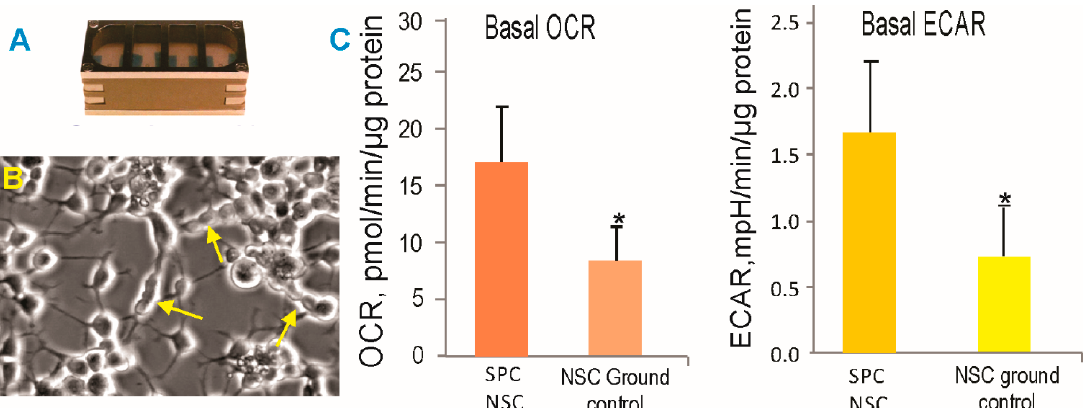
Figure 3. SPC-NSCs and ground control NSCs were recovered from the passive hardware ( A ) and treated in the same manner. ( B ) Representative example of post-flight NSCs that continued to actively proliferate, as shown by the arrows. ( C ) After 39.3 days in space, NSCs display enhanced energy consumption. OCR—oxygen consumption rate; ECAR—extracellular acidification rate; SPC-NSCs in the space environment. Each experiment consisted of n = 12. The values are expressed as mean + SD. * The Student's t test revealed that these differences were significant (p < 0.05).